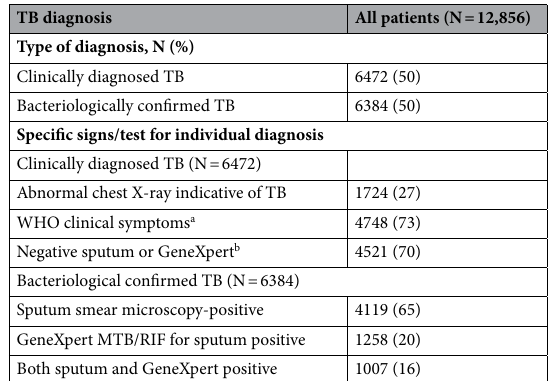
Table 2. Diagnosis of TB at the time of starting anti-TB treatment. a Individual WHO clinical signs not available. b Proportion of the total clinically diagnosed TB cases who had a negative sputum or GeneXpert test.